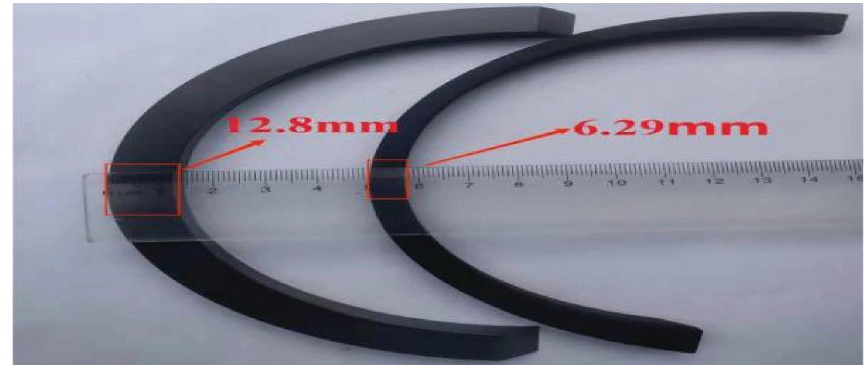
Figure 28: Comparison of early and late piston ring